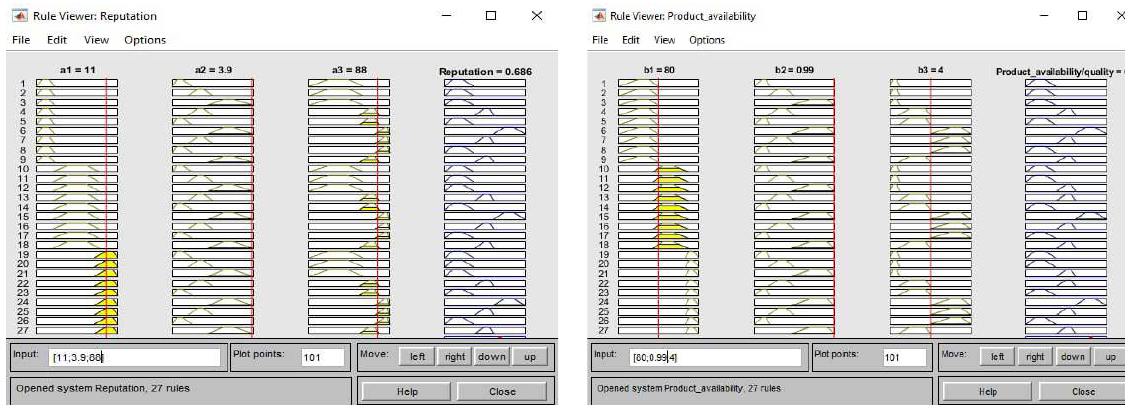
Figure 8. Implemented data defuzzification to the final level of the developed fuzzy model – an integral indicator of the quality of logistics service for Company No.